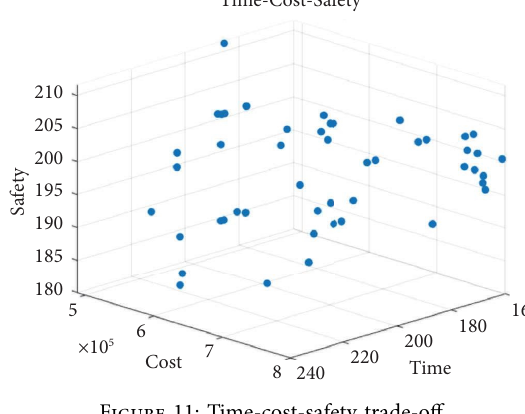
Figure 11: Time-cost-safety trade-of.